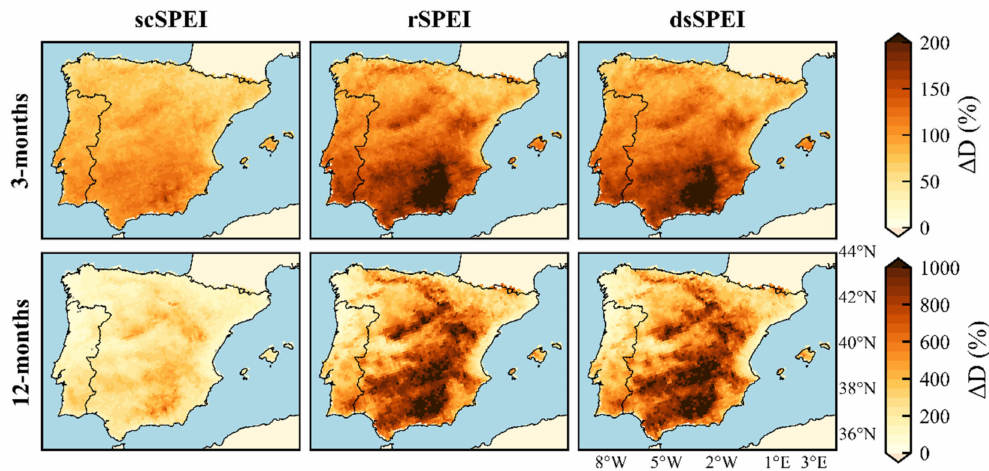
Figure 10. As Figure 9, but for the mean drought duration ( ∆ D, %).